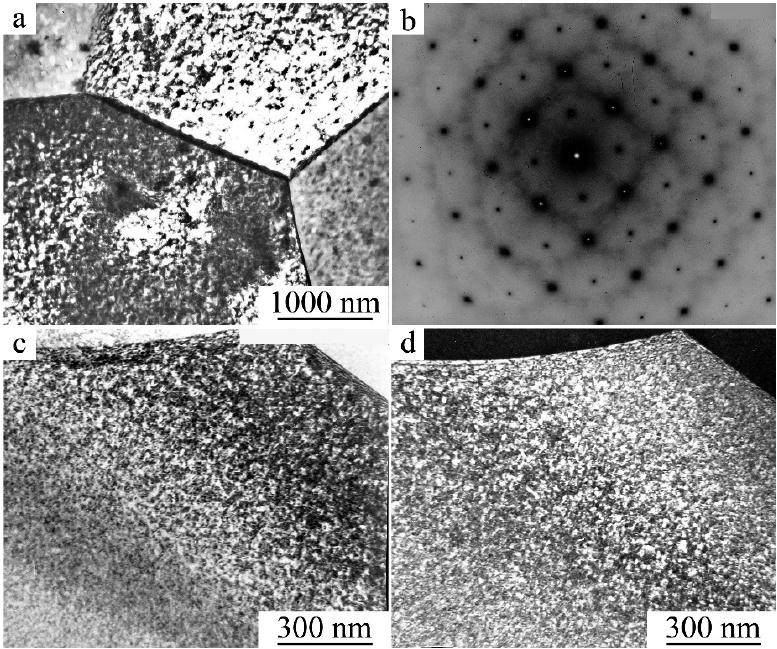
Figure 15. ( a , c ) Bright- and ( d ) dark-field TEM images of the microstructure, and ( b ) the corresponding SAED pattern (z.a. [100] B 2 , SD 1.0 µ m), from the Ti 49 Ni 51 alloy after HT at 573 K for 1 h.